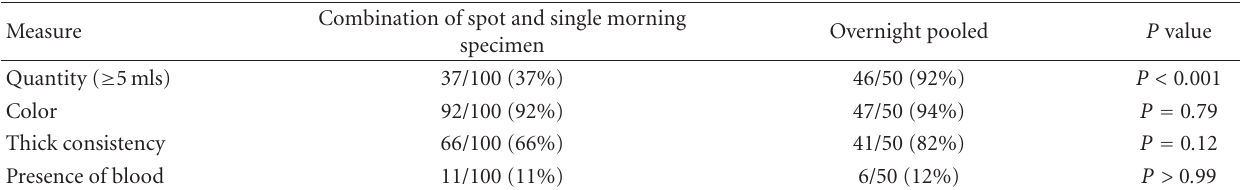
Table 2: Comparison of overnight pooled and spot method of collection on quality and quantity of sputum.